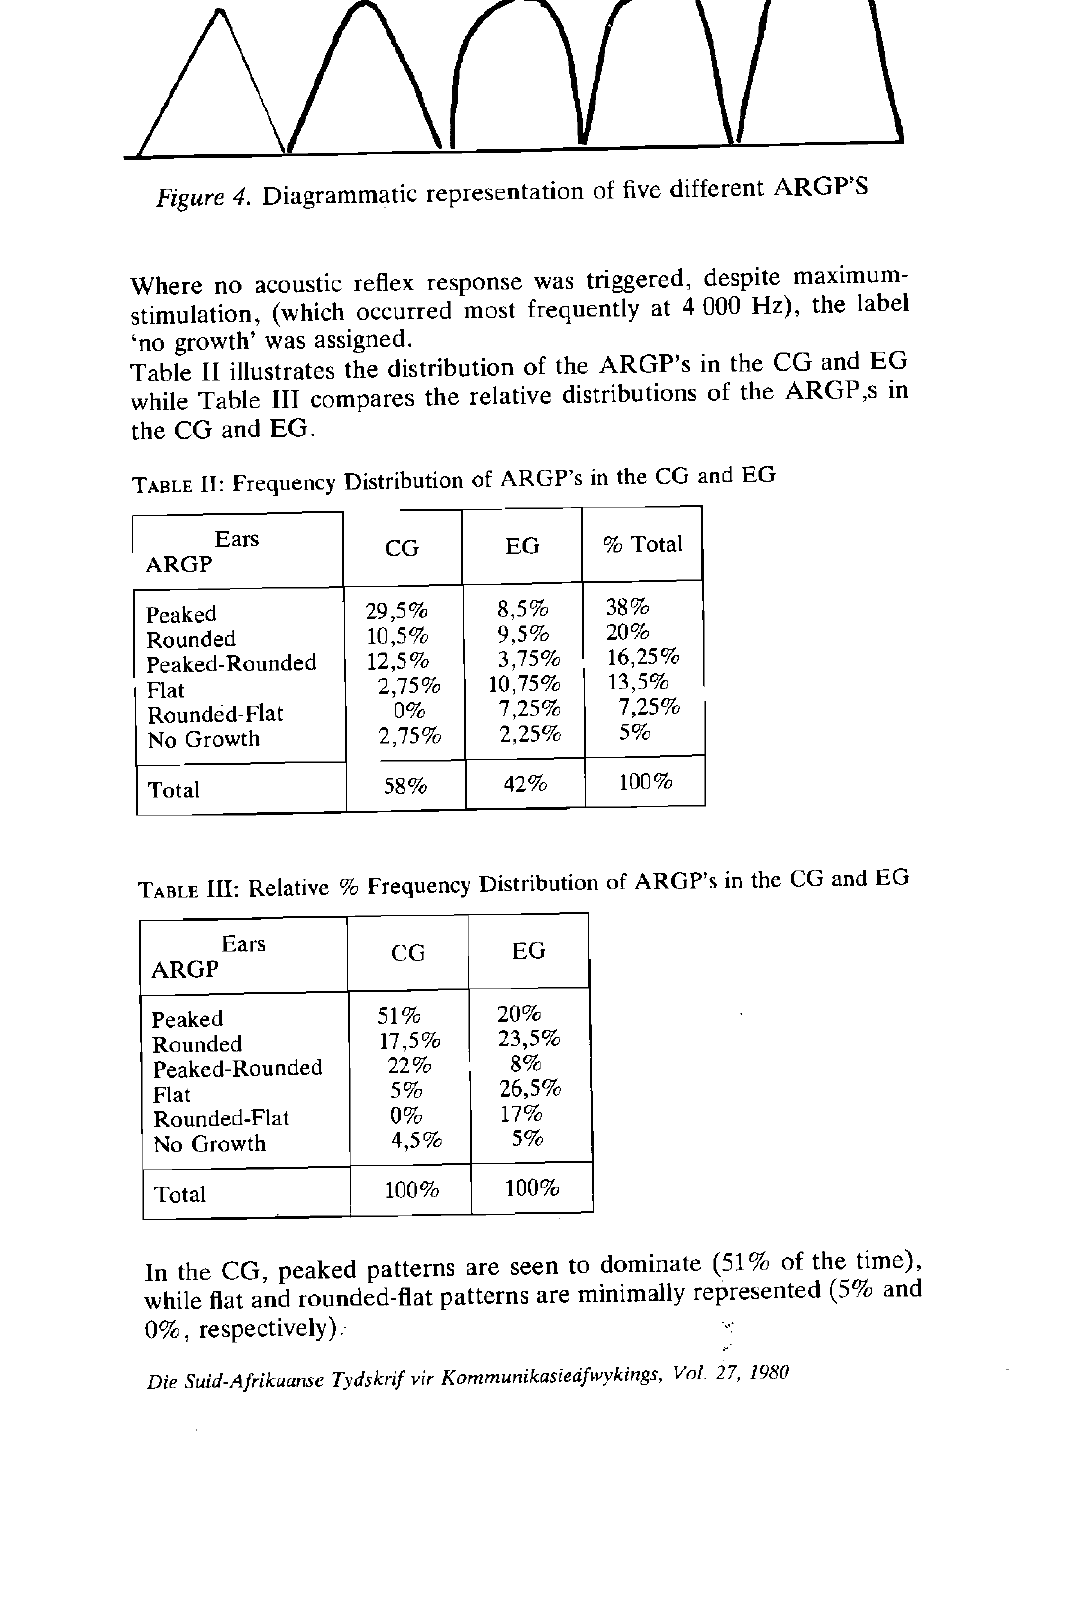
Figure 4. Diagrammatic representation of five different ARGP'S